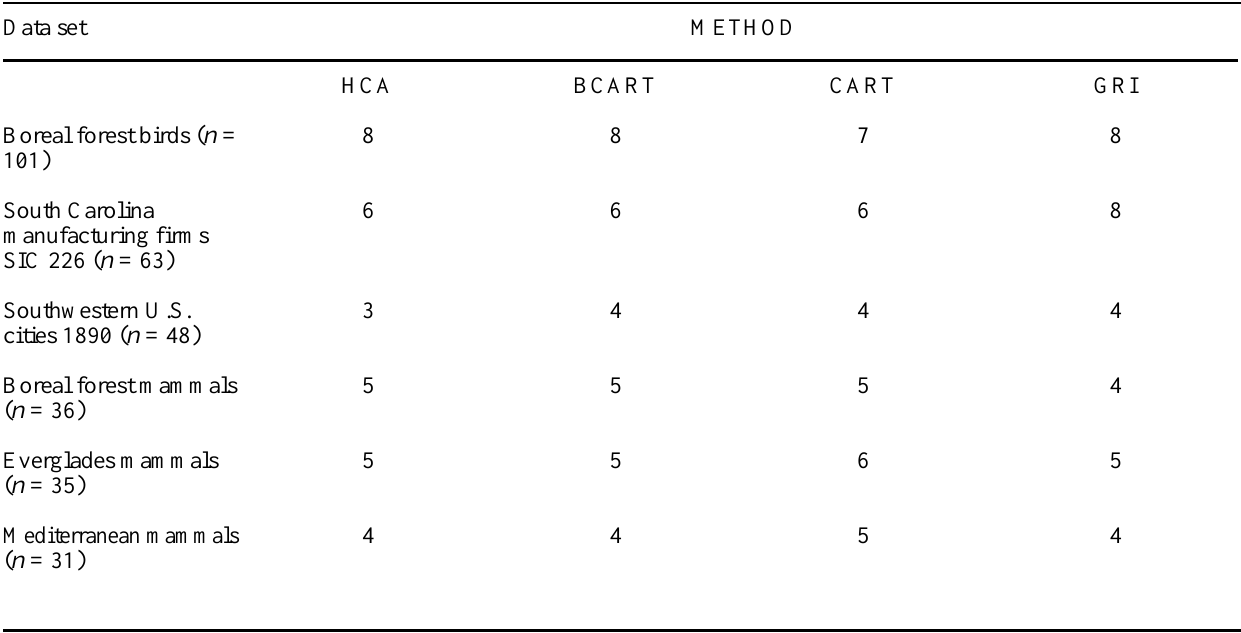
Table 2. The number of discontinuities detected in six data sets by hierarchical cluster analysis (HCA), Bayesian classification and regression tree (BCART), classification and regression tree (CART), and gap rarity index (GRI).